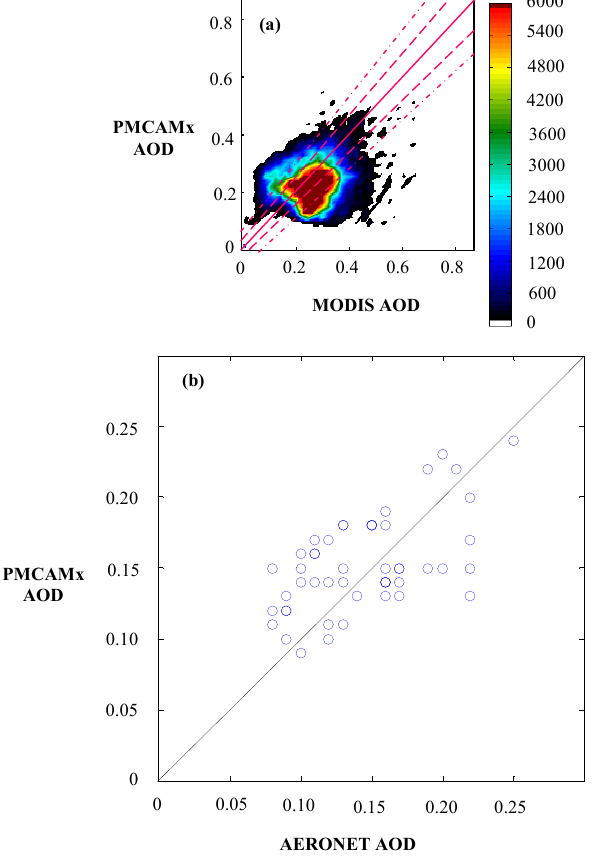
Figure 5. (a) Comparison of the PMCAMx predictions with MODIS (QAC ≥ 1) monthly mean AODs. The different colors in- dicate density. The dashed red lines denote the ocean expected er- ror envelope and the dotted lines denote the land envelope which describes MODIS AOD uncertainties with respect to AERONET (see Sect. 3). The solid red line is the 1 : 1 line. (b) Comparison of the PMCAMx with AERONET monthly mean AODs. The PM- CAMx values correspond to the periods of measurement for the 50 AERONET